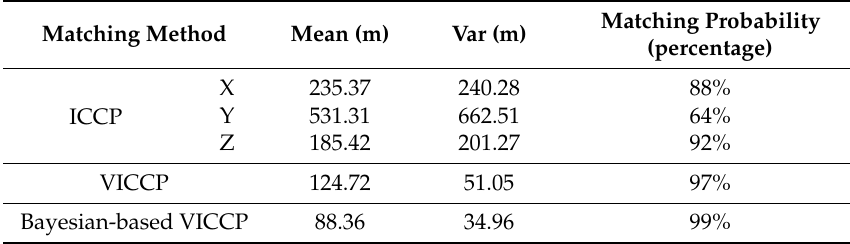
Figure 7. Evaluation the performance of Bayesian-based algorithm. Table 5. Evaluation of the performance of the Bayesian based algorithm with 100 times Monte Carlo simulation.